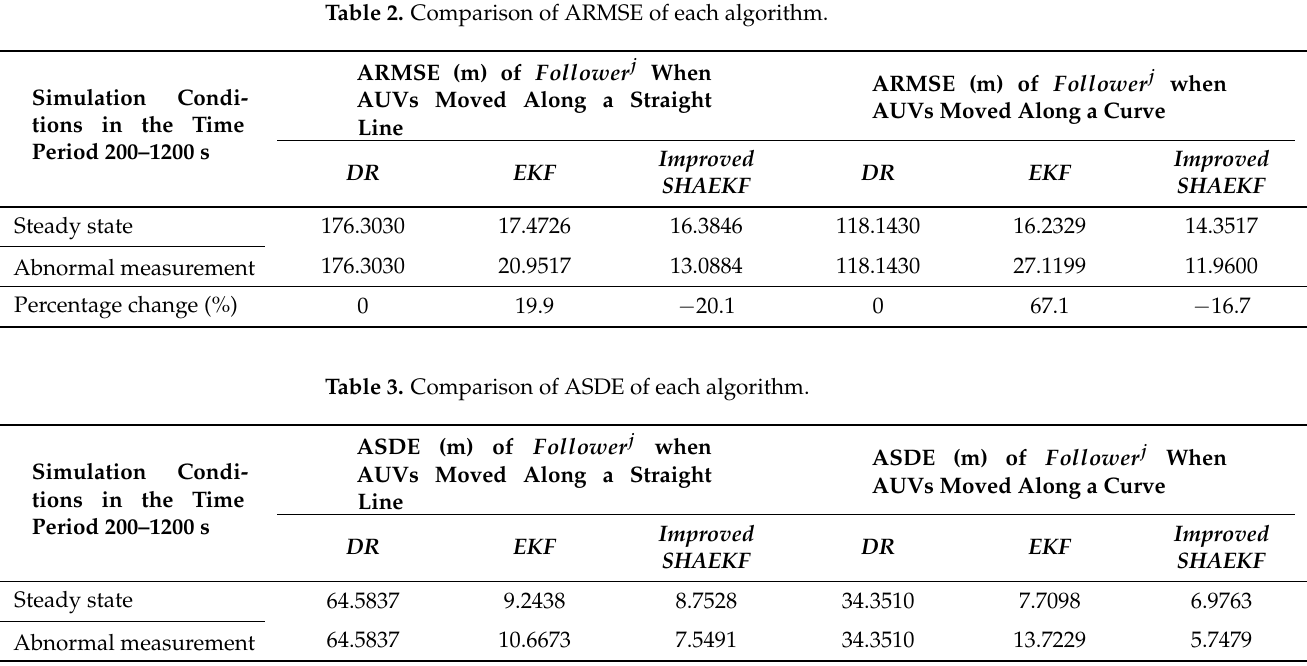
Table 2. Comparison of ARMSE of each algorithm.